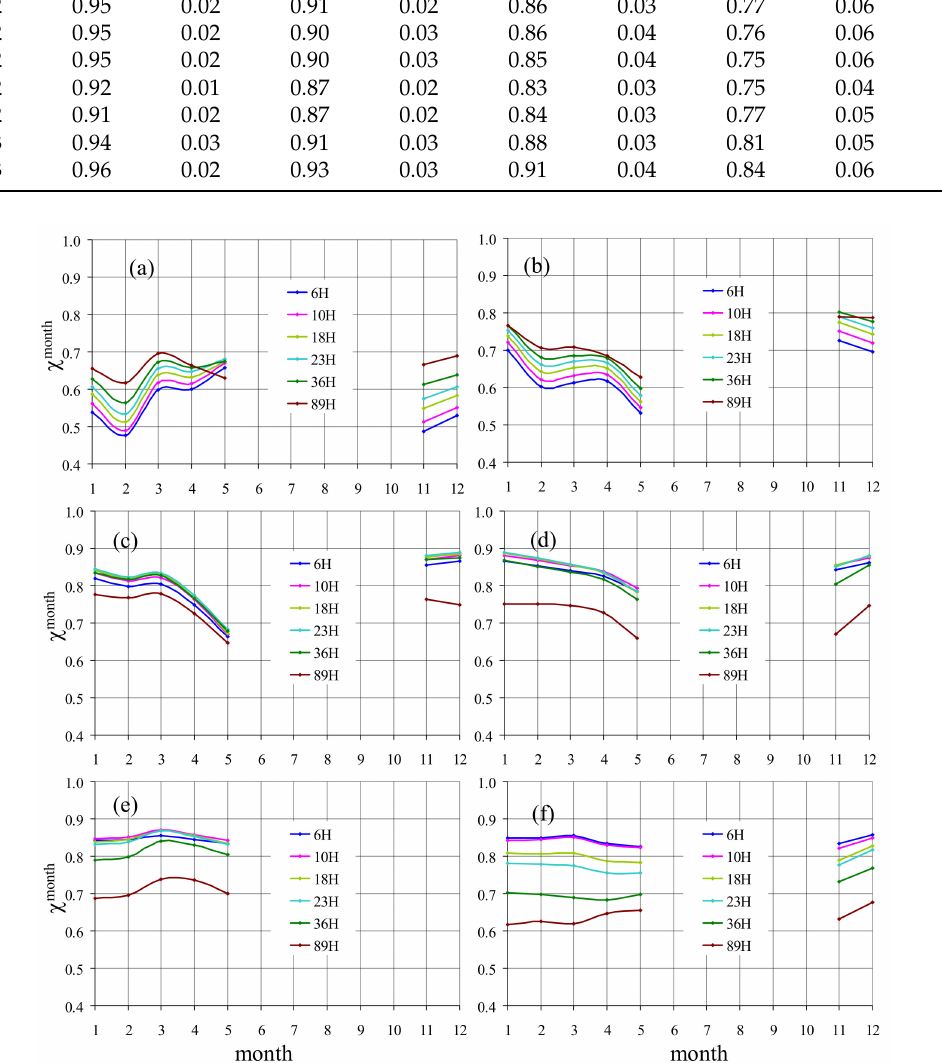
Figure 6. Monthly averaged values of χ at 6.9, 10.65, 18.7, 23.8, 36.5 and 89 GHz with horizontal polarization (06H, 10H, 18H, 23H, 36H and 89H, correspondingly). ( a )—nilas, ( b )—young ice, ( c )—thin FY ice, ( d )—medium FY ice, ( e )—thick FY ice, ( f )—MY